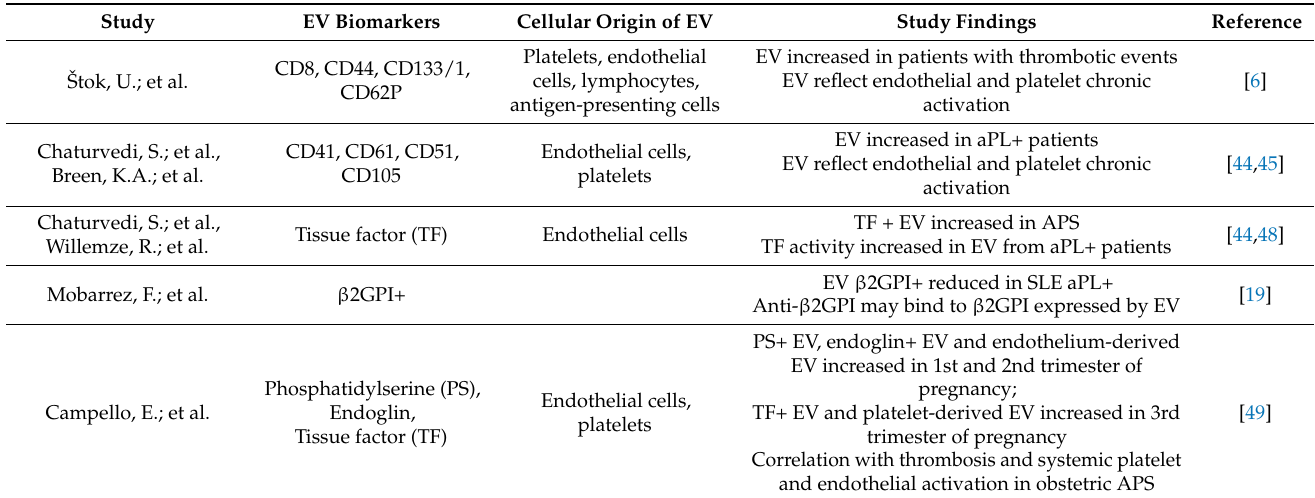
Table 1. Extracellular vesicles in antiphospholipid syndrome